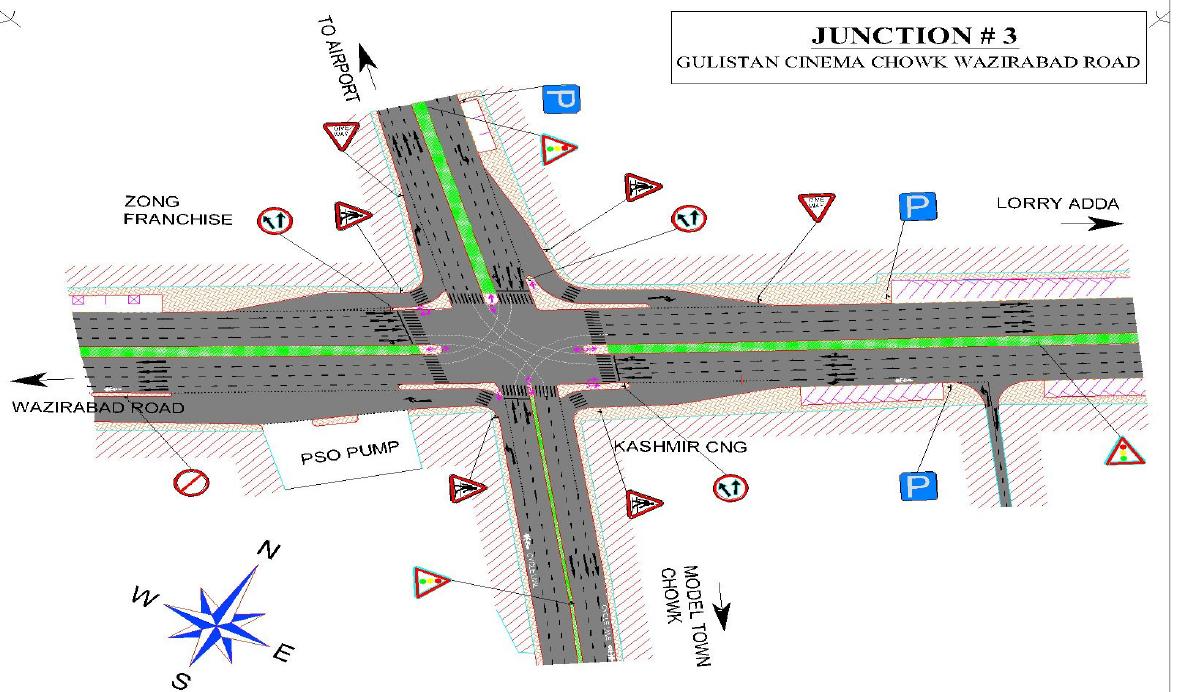
Fig. 12: Modified Design of Gulistan Cinema Intersection